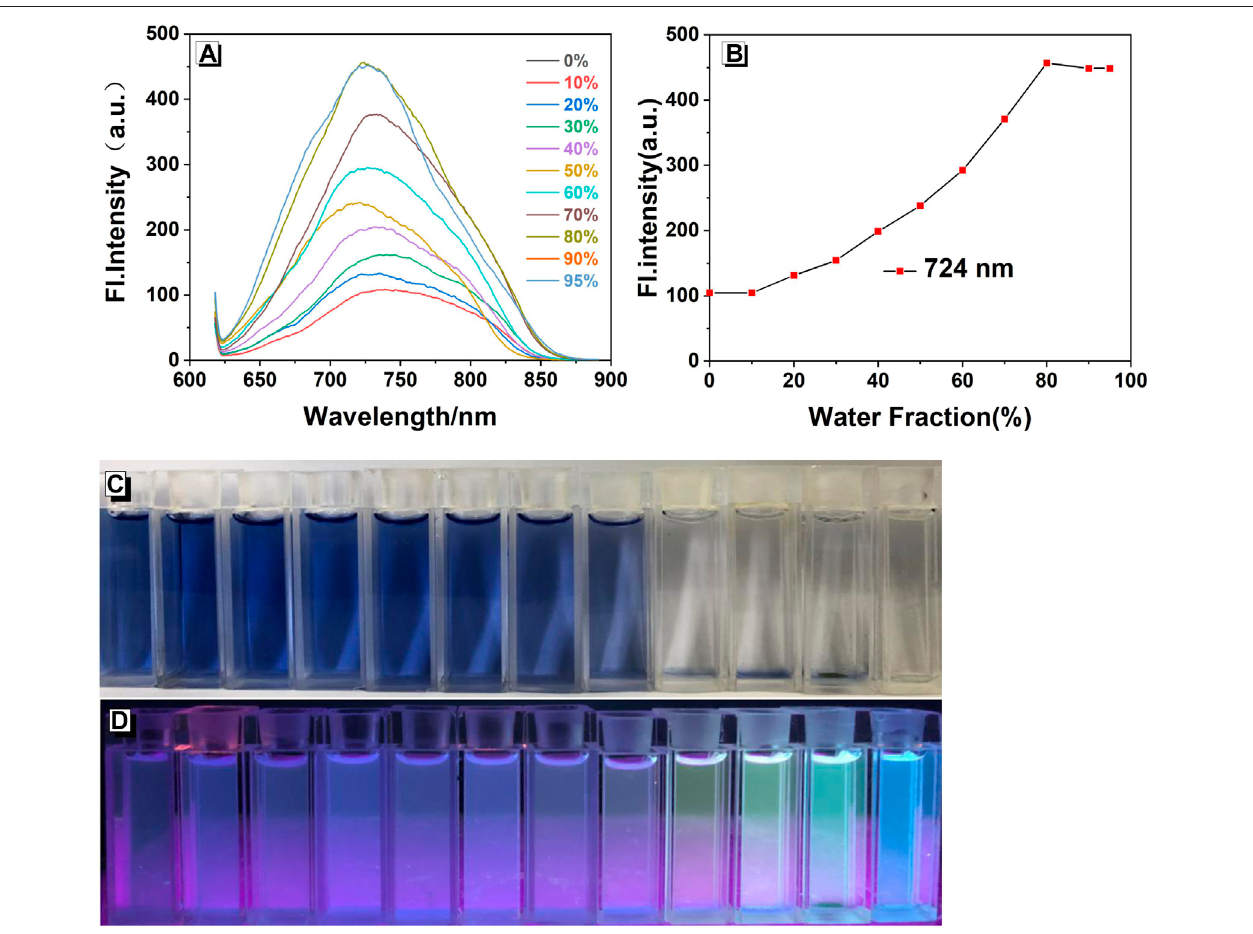
FIGURE 1 | (A) Fluorescence spectra of W (20 μ M) in EtOH/water mixtures with different water fractions ( λ ex/ λ em = 378 nm/724 nm, slit: 5/5 nm, and voltage: 800 V). (B) Plots of fl uorescenceintensityat 724 nm.PhotographsinEtOH/watermixtureswith differentwater fractions takenunder (C) natural lightand (D) 365 nm UV